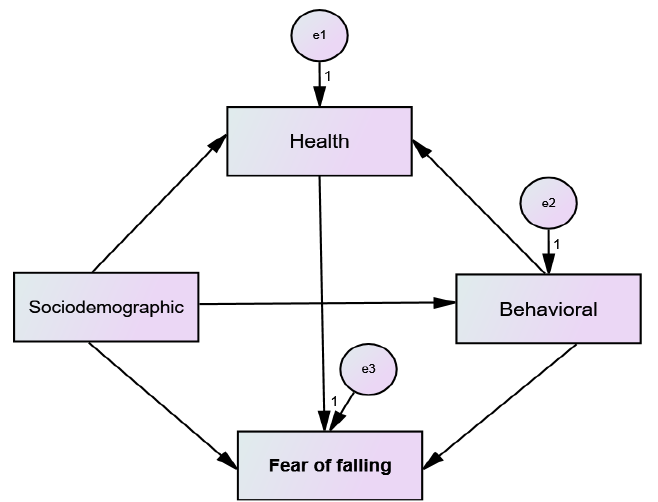
Figure 1. Hypothetical model tested.